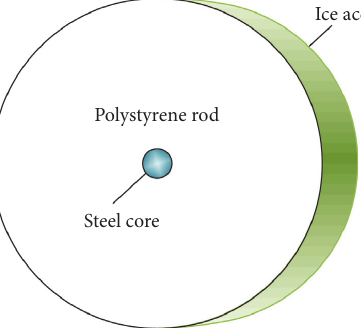
Figure 9: Cross-section of the model.